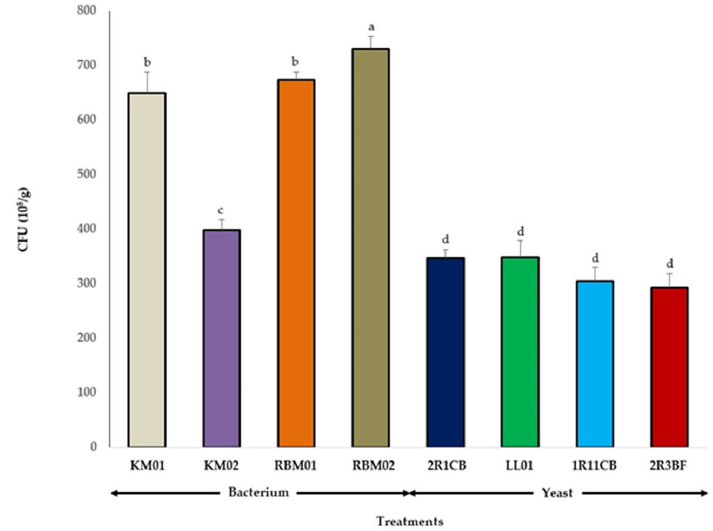
Figure 4. Colony forming units (CFU) in the roots of ancho-type pepper plants inoculated with different marine strains of bacteria and yeasts. The bacteria are Stenotrophomonas rhizophila (KM01 and KM02) and Bacillus subtilis (RBM01 and RBM02), and the yeasts are Cryptococcus laurentii (2R3BF and 2R1CB) and Debaryomyces hansenii (1R11CB and LL01). Data are shown as the mean ± standard deviation (SD) ( n = 10). Columns with different letters were significantly different according to Tukey’s test ( p < 0.05).